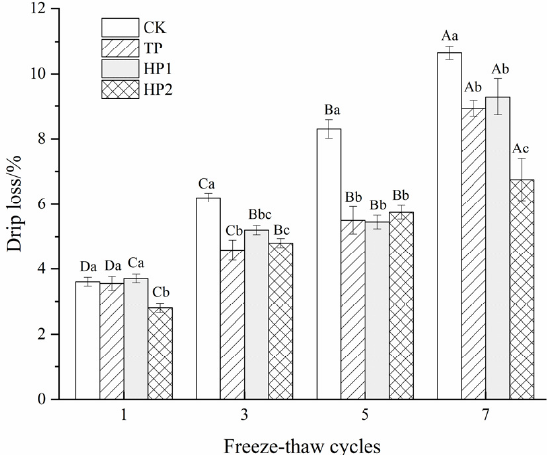
Figure 7. Changes in drip loss of freeze-thawed fish fillets: CK: fillets in distilled water; TP: fillets in tea polyphenol; HP1: fillets in 1% bone hydrolysates; HP2: fillets in 2% bone hydrolysates. Different capital letters indicate that the results differ significantly in freeze–thaw cycles with the same treatment ( p < 0.05). Different lowercase letters indicate that the results differ significantly with different treatments in the same freeze–thaw cycle ( p < 0.05).